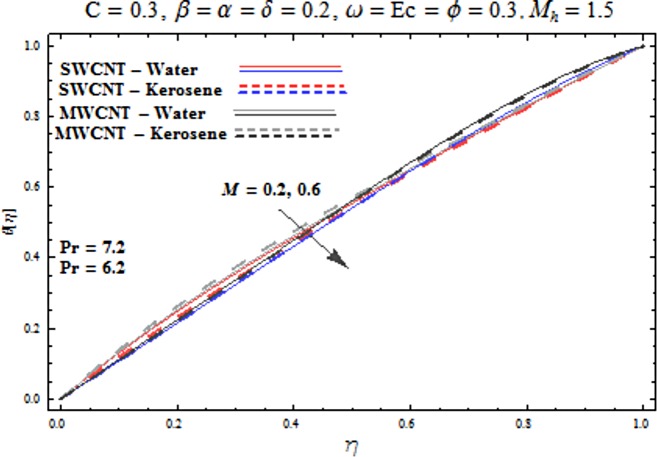
Effect of M on θ.